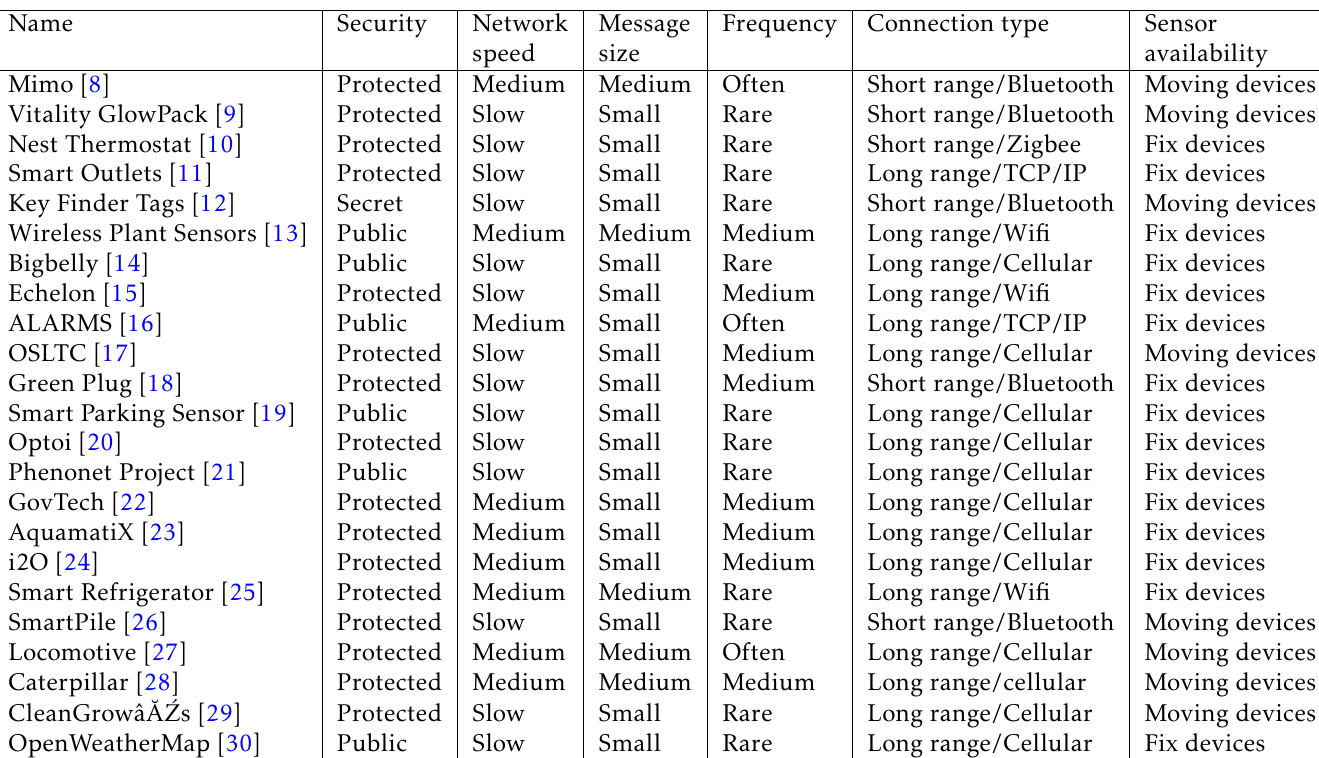
Table 2. Comparison table of IoT Use Cases - Part